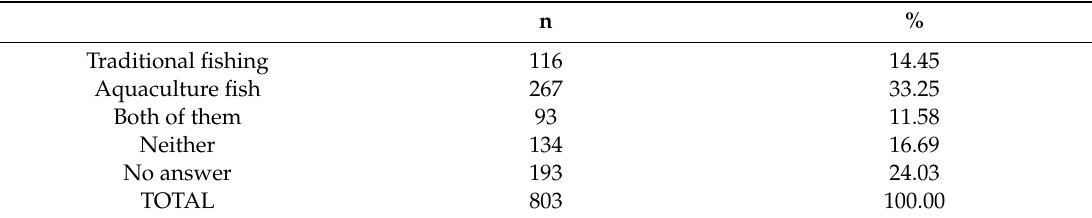
Table 8. Perception of support from governments. n